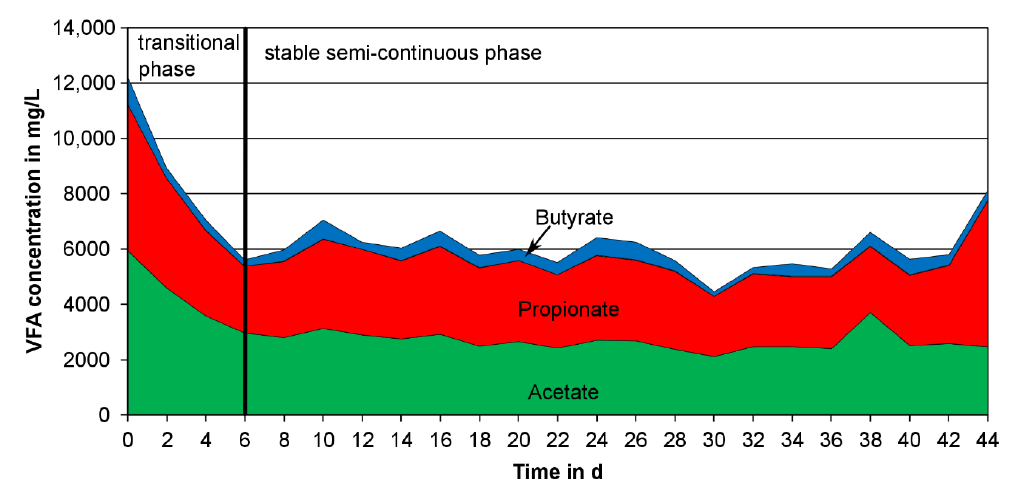
Figure 6. Development of the VFA concentration and composition at RT = 4 days, WD = 50%